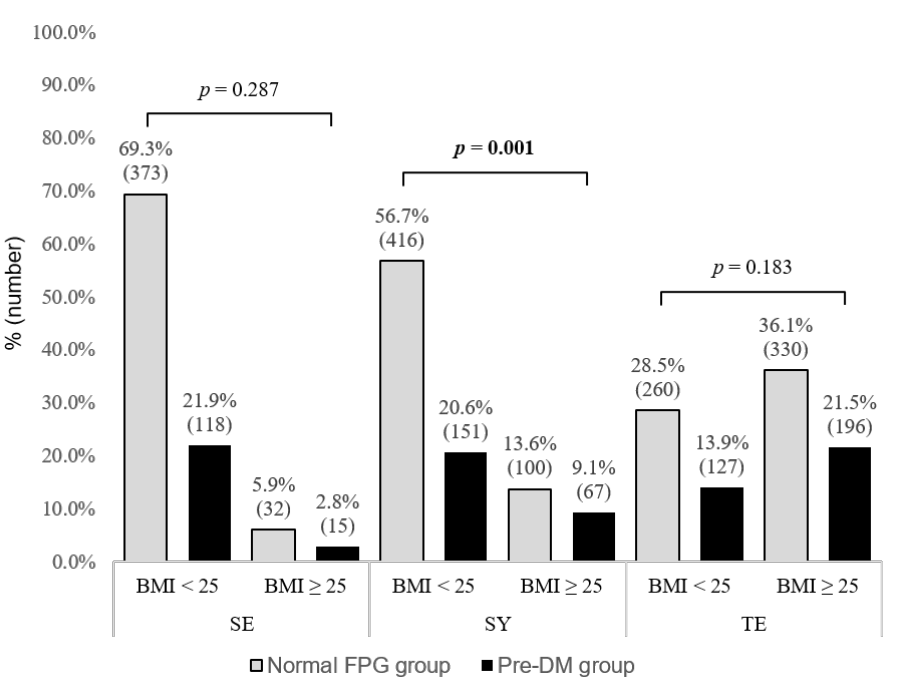
Figure 3. Proportion of normal individuals and individuals with prediabetes stratified by BMI among individuals with SE, SY and TE types. BMI: body mass index, SE: Soeumin, SY: Soyangin, TE: Taeeumin, FPG: Fasting plasma glucose. Boldface type indicates statistical significance.